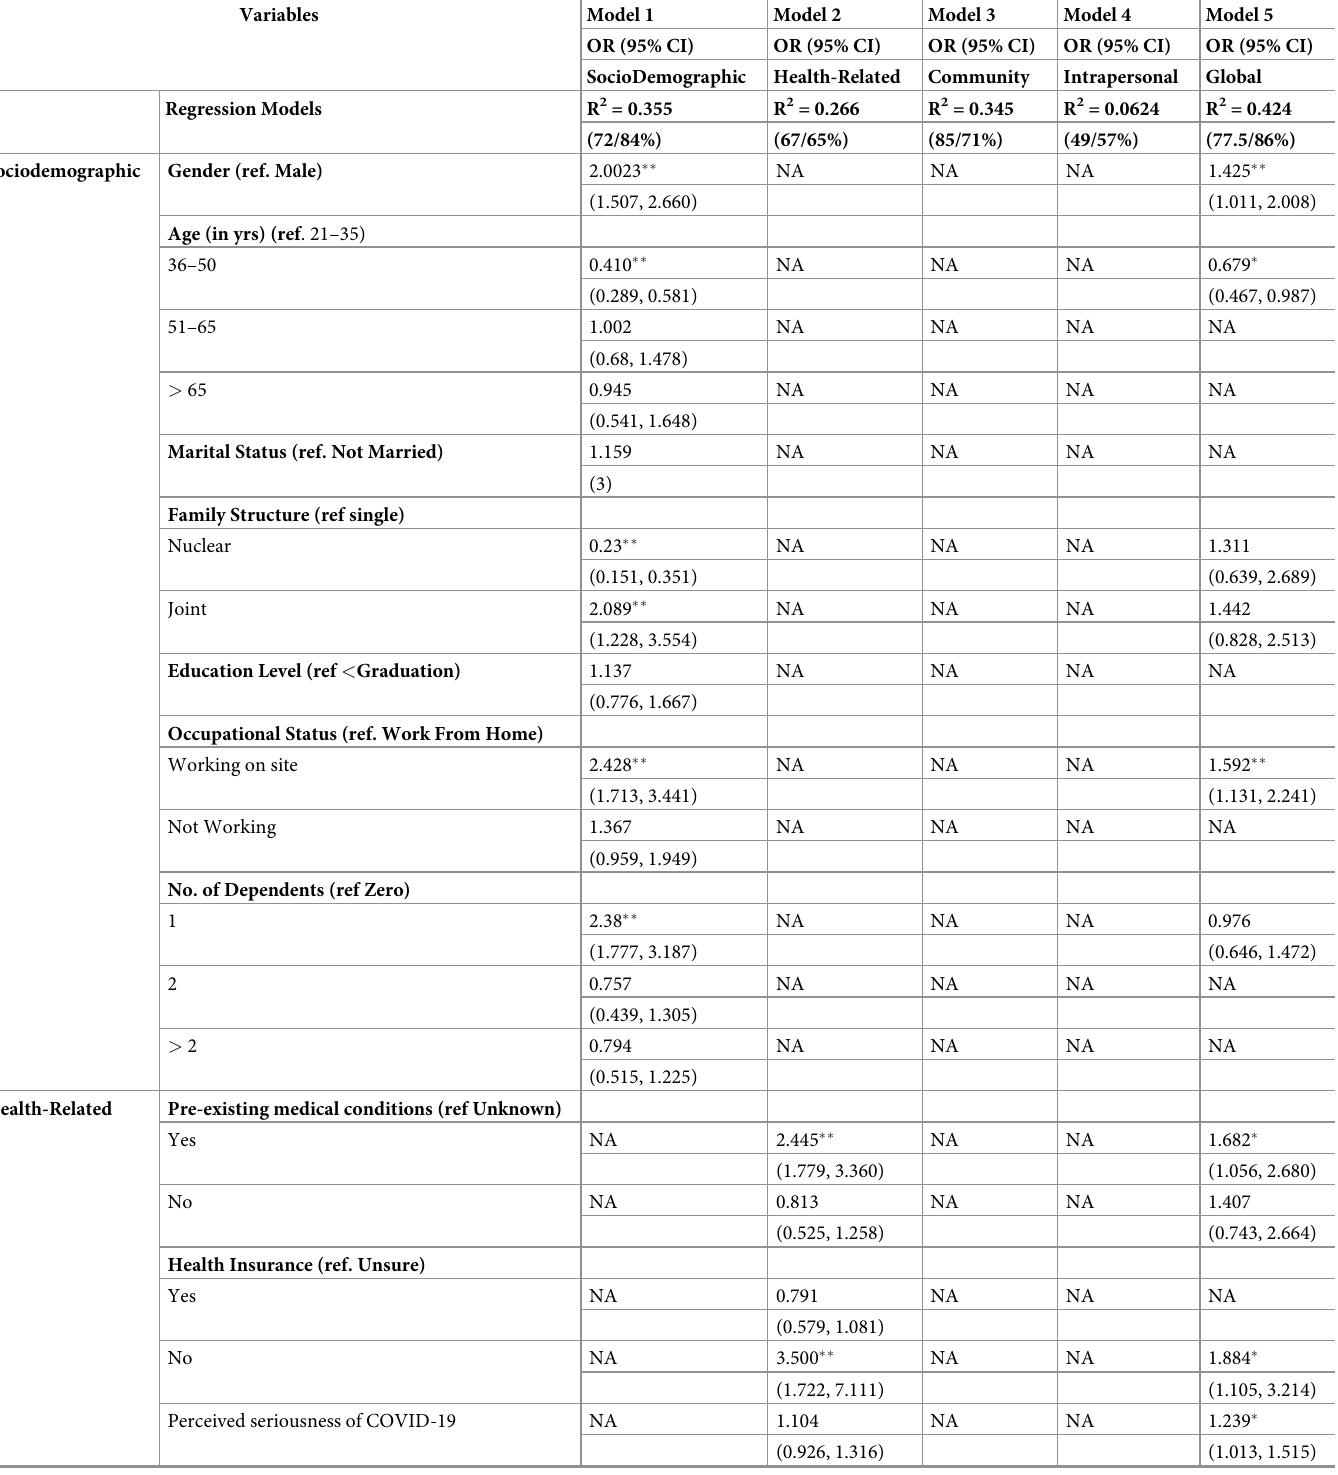
Table 2. Logistic regression